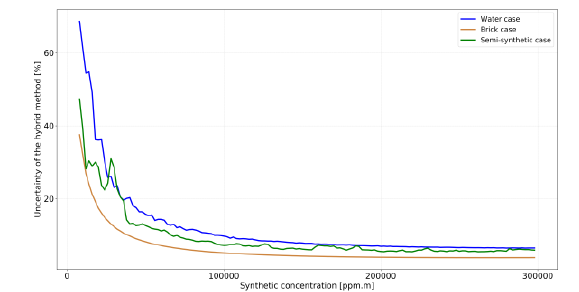
Figure 11 . Uncertainty of the hybrid method for the two full- synthetic cases and the semi-synthetic case, in